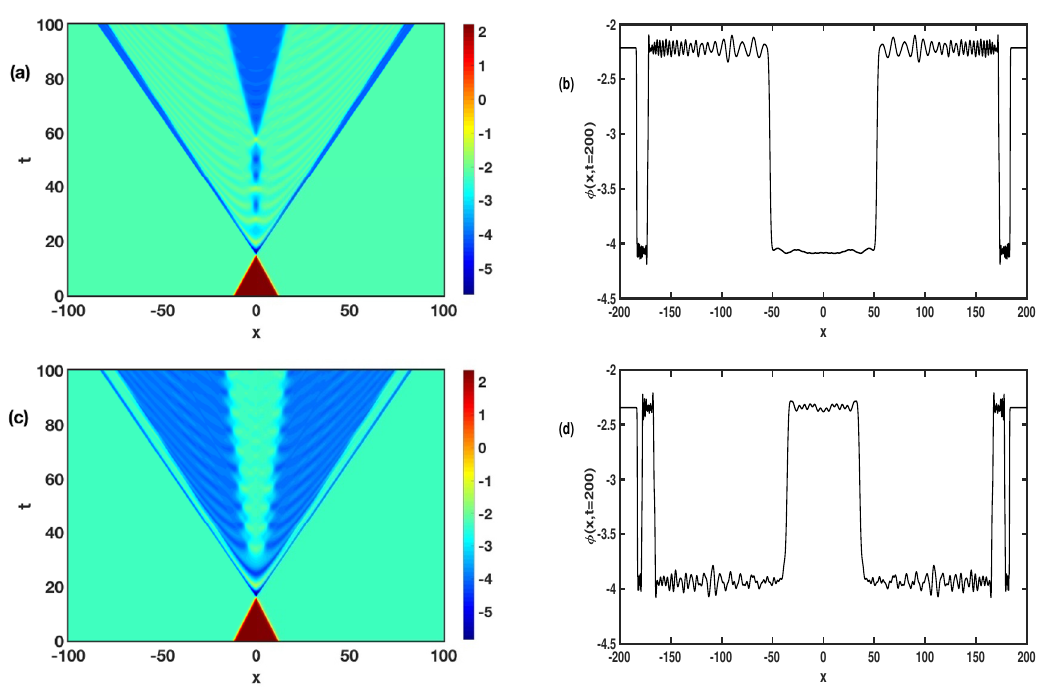
Figure 8 . Large kink-antikink collision (left) and image of last simulation time of scalar field as a function of x (right) for a) b) r = 0 . 6, v = 0 . 8, with production of three small kink-antikink pairs and c) d) r = 0 . 7, v = 0 . 74, with production of four small kink-antikink pairs.